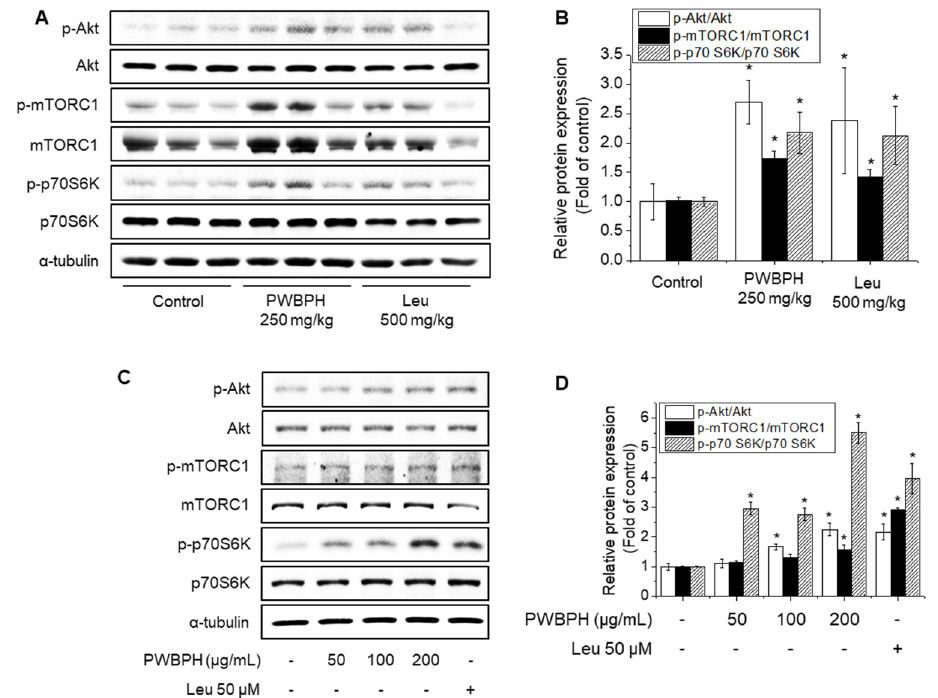
Figure 4. Effects of PWBPH treatment on the Akt/mTOR signaling pathway in vivo and in vitro. ( A ) Phosphorylation levels of Akt, mTOR, and p70S6K in the Gas muscle of the control, PWBPH 250 mg/kg, and Leu 500 mg/kg groups were determined by Western blotting. ( B ) The band intensities were measured using Image J software. Data are shown as the means ± SD ( n = 3). * p < 0.05 vs. control group. C2C12 cells were treated with DM alone, or DM supplemented with PWBPH (50–200 μ g/mL), or Leu (50 μ M) for 4 days. ( C ) Phosphorylation levels of Akt, mTOR, and p70S6K were determined by Western blotting. ( D ) The band intensities were measured using Image J software. Data are shown as the means ± SD from three independent experiments. * p < 0.05 vs. control group.